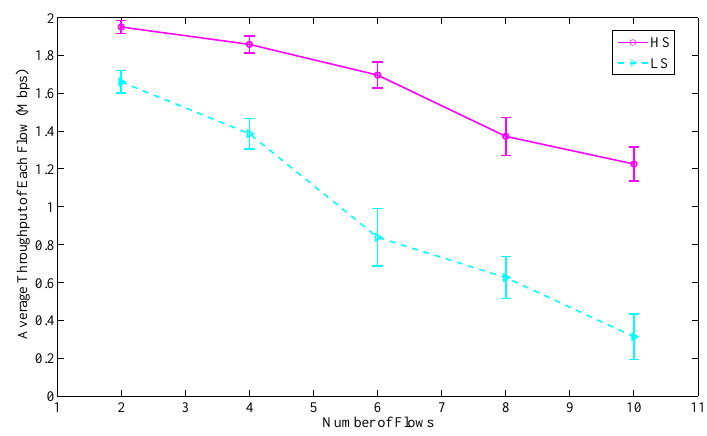
Figure 11. The throughput comparison of different service priority information.